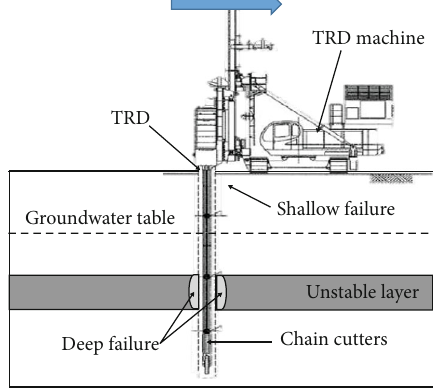
Figure 7: Nonpressure seepage on impervious foundation under vertical boundary